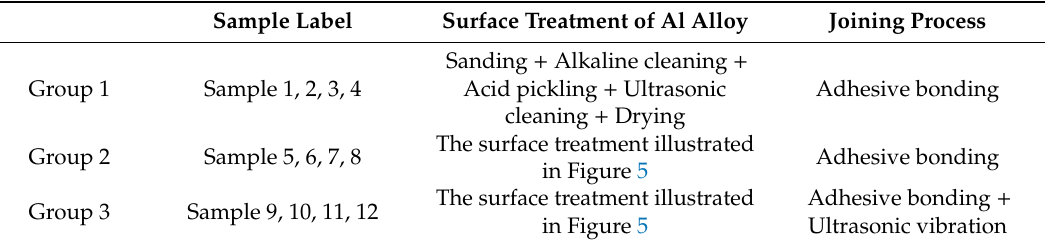
Table 2. Three experiments of di ff erent surface treatments and joining processes.